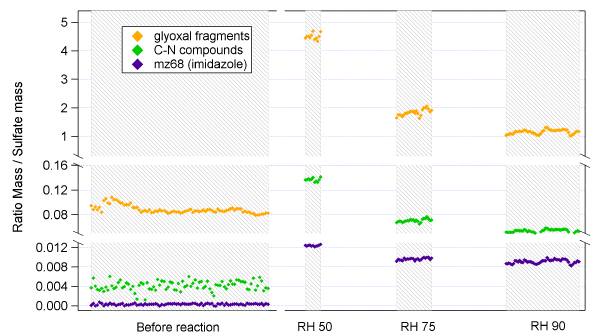
Fig. 4. The total glyoxal fragments (orange diamonds), total C-N compounds (green diamonds) and m/z 68 (imidazole) (purple dia- monds) normalized to sulfate (SO 4 ) mass for the reaction of AS 300nm particles with glyoxal are presented for 4 periods: (a) be- fore the reaction (pure AS particles), (b) after ∼ 1h reaction at RH 50%, (c) after ∼ 1h reaction at RH 75%, and (d) after ∼ 1h reaction at RH